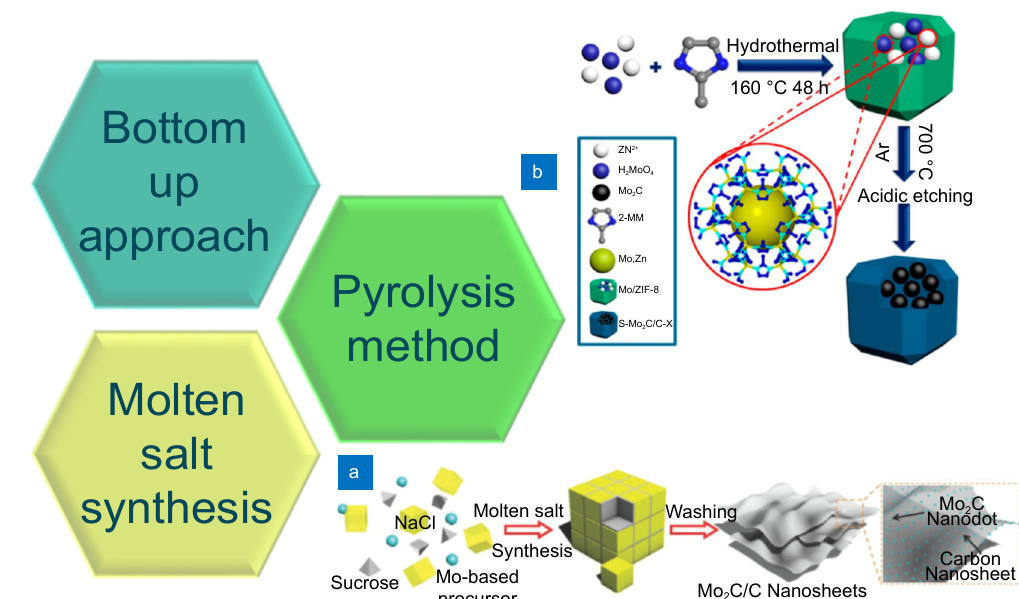
Fig. 5 | Types of bottom-up synthesis processes. The figures were reproduced from: ( a ) ref. 82 . Copyright 2018, John Wiley and Sons; ( b ) ref. 83 , Copyright 2018, American Chemical Society.